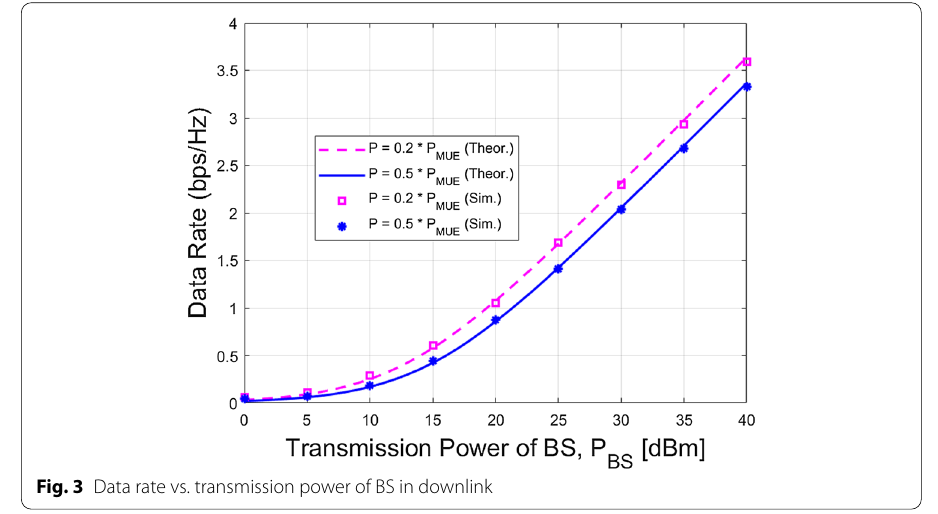
Fig. 3 Data rate vs. transmission power of BS in